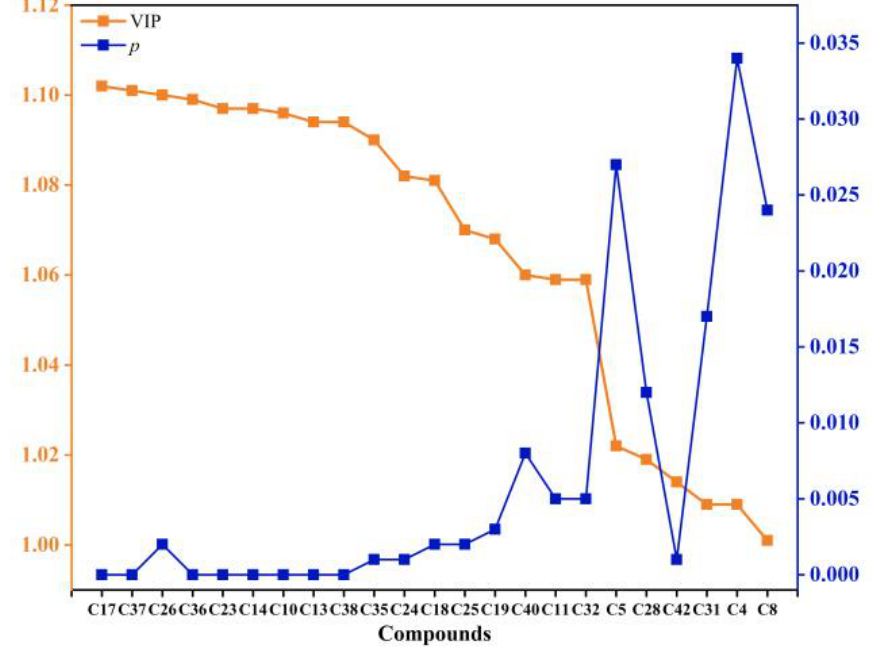
Figure 4. Line plots of VIP and p of key volatile compounds based on VIP > 1 and p <